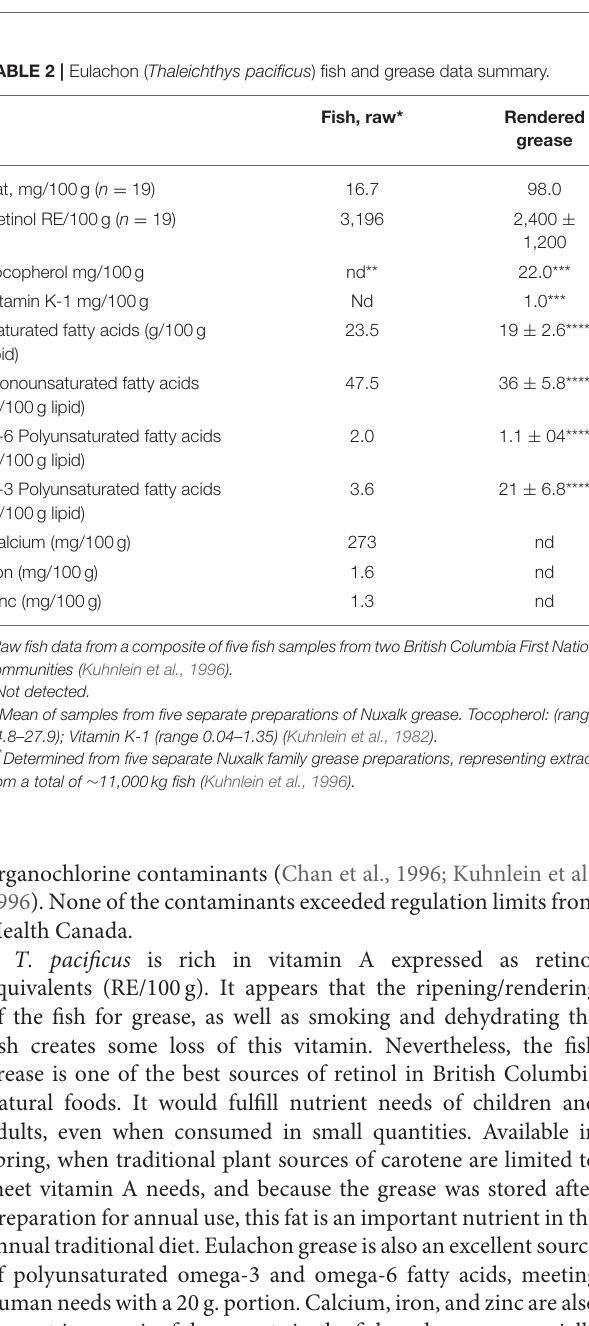
TABLE 2 | Eulachon ( Thaleichthys pacificus ) fish and grease data summary.